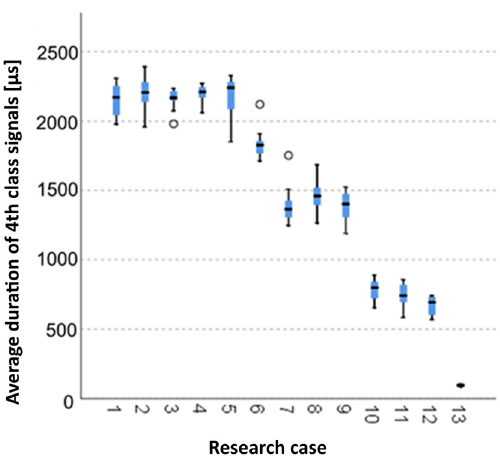
Figure 27. The graphical representation of the Kruskal–Wallis test results for independent tests of the average duration of the class 4 signals.